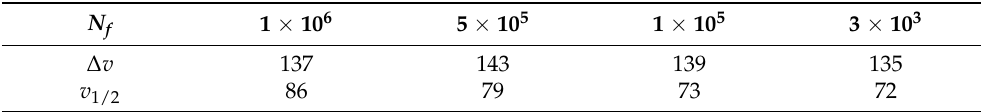
Table 2. The variation in the NH stretching band after